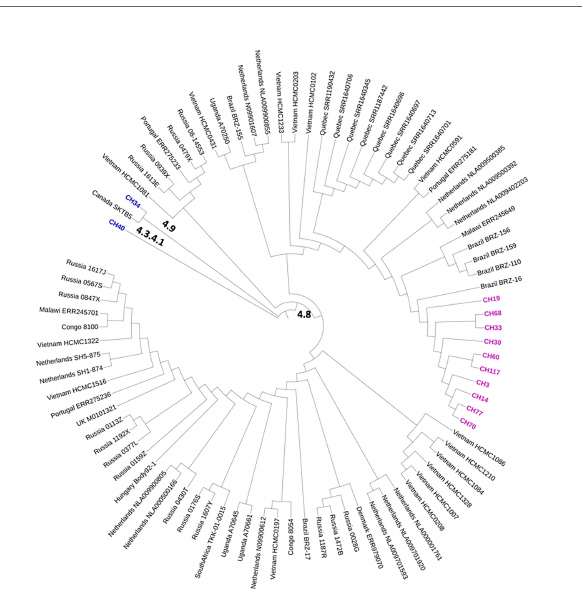
FIGURE 3 | Comparative phylogeography of a 4.8 global dataset with the genomes of the SIT43 MTB isolates from Los Altos de Chiapas. In the map, we show in pink the cluster formed by the 4.8 isolates. In blue, other SIT53 isolates belonging to different 4.0 lineages are represented. The genome sequences were obtained from those published and deposited in GenBank by Brynildsrud et al.